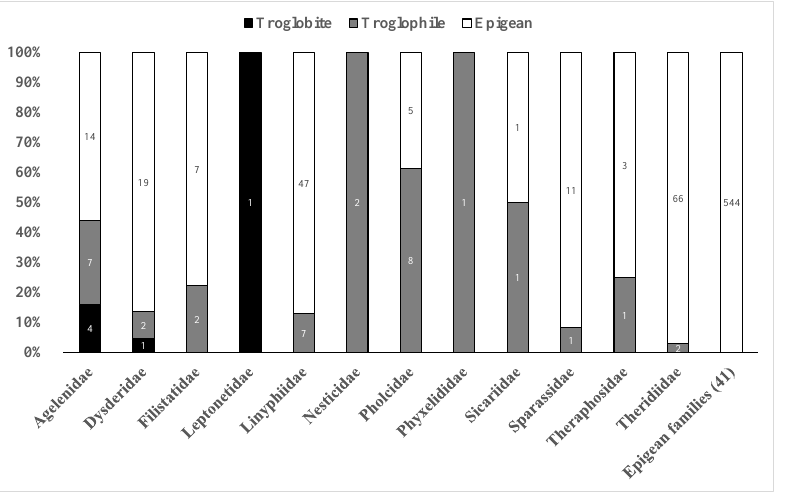
Figure 7. Proportion and number of troglobite, troglophile, and epigean spider species per family in Israel and Palestine (53 families and 758 species including undescribed species, description in progress). Families that have only epigean species were pooled in one